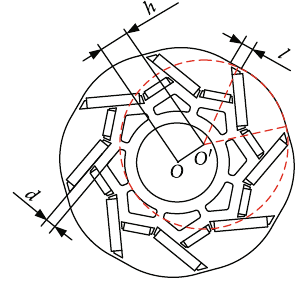
Figure 4: Rotor structure optimization.